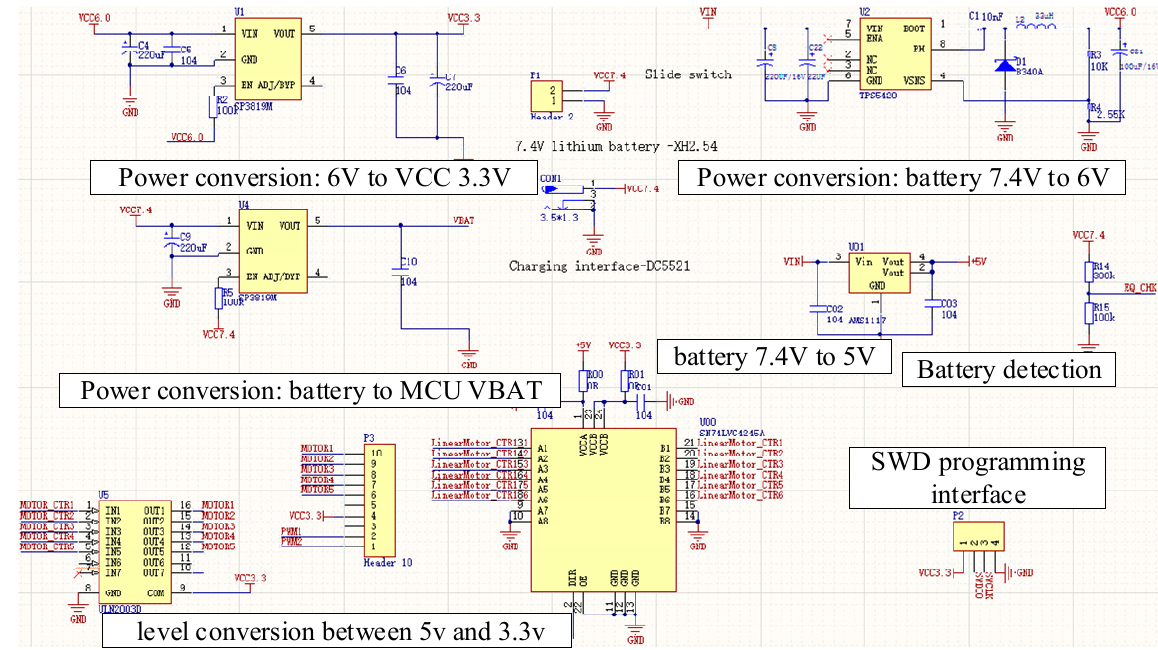
Figure 4. Schematic diagram of step-down circuit and level conversion. Stm32f405 chip is used for the main control of the hand function robot, as shown in Figure 5.